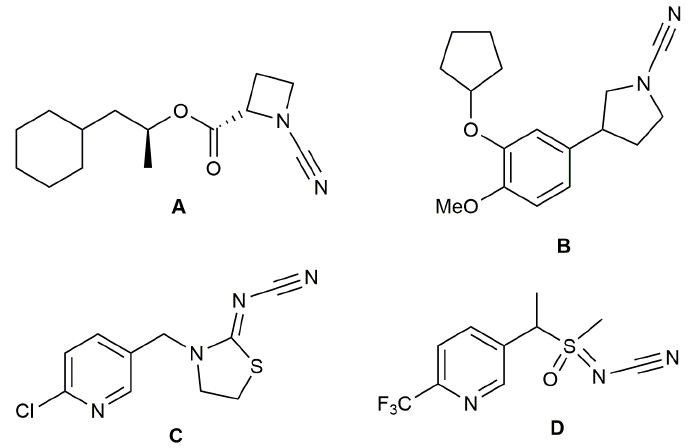
Figure 1. Structure of the biologically active cyanamides ( A – D ).